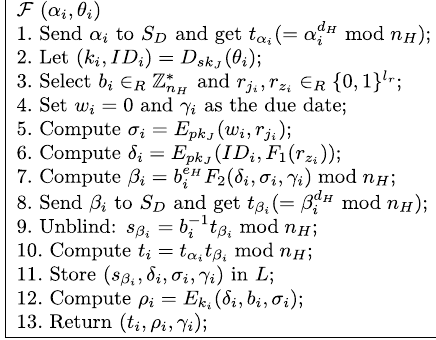
Figure 7. The forger F